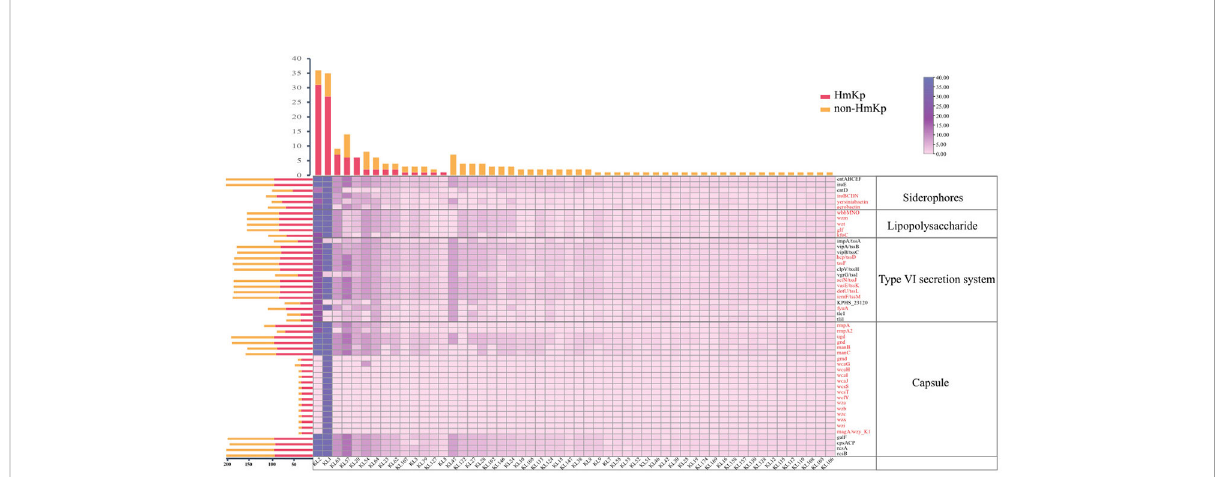
FIGURE 2 Distributions of siderophores, lipopolysaccharide, type VI secretion system, and capsule-related genes among serotypes. The bar graph (top) represents the numbers of isolates by serotype. The bar graph (left) represents the numbers of virulence genes in two groups. Groups are indicated by different colors. The numbers of virulence genes are depicted as a heatmap. The red font represents genes that were signi fi cantly more prevalent in the HmKp group than in non-HmKp group.